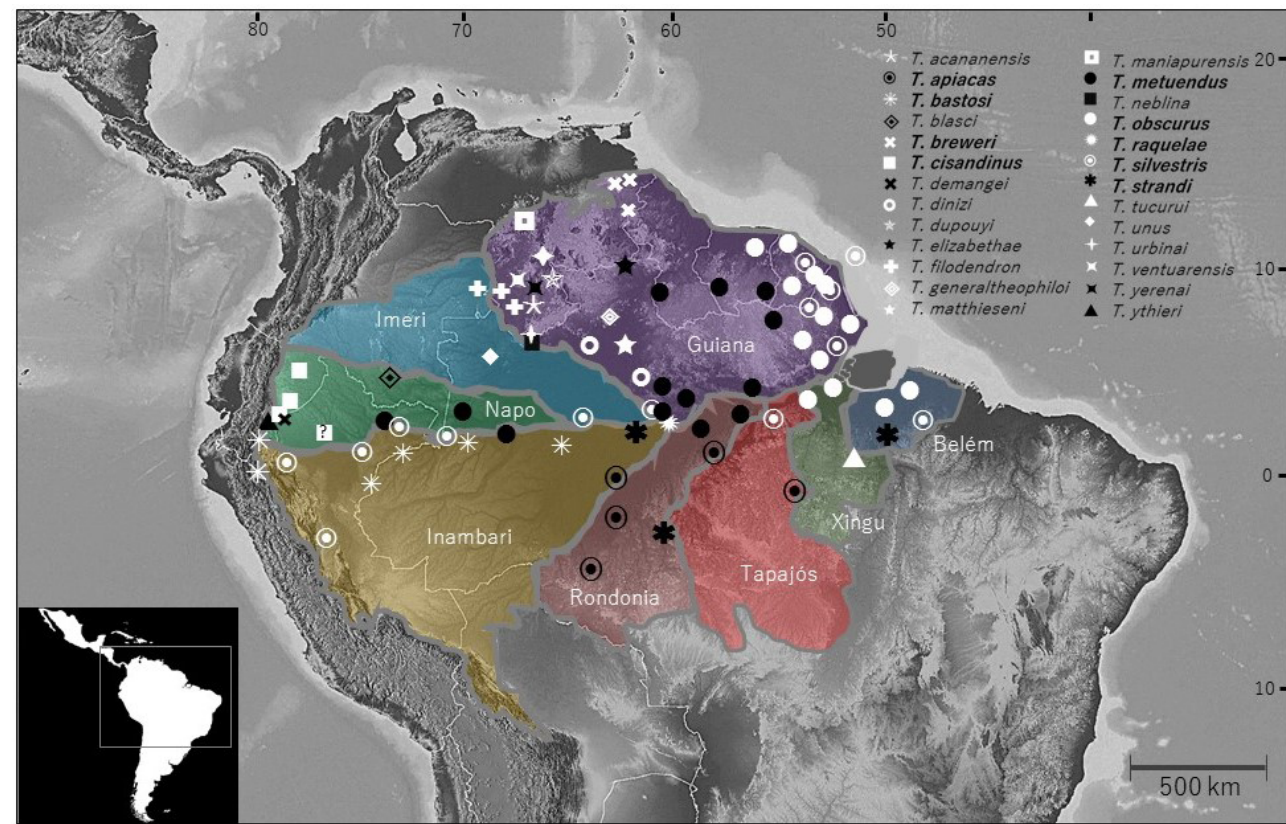
Figure 1. Distribution map of representative Amazonian Tityus species, superimposed on the areas of endemism defined for Amazonia [17]. Distribution areas for Brazilian, Colombian, Ecuadorean, Peruvian, and French Guiana taxa [20, 23, 29, 30, 31, 32, 33] and distribution areas for Venezuelan taxa [27, 28]. T. cisandinus distribution in Peru has been posited but not demonstrated [34]. Species names in boldface correspond to medically important species (see Table